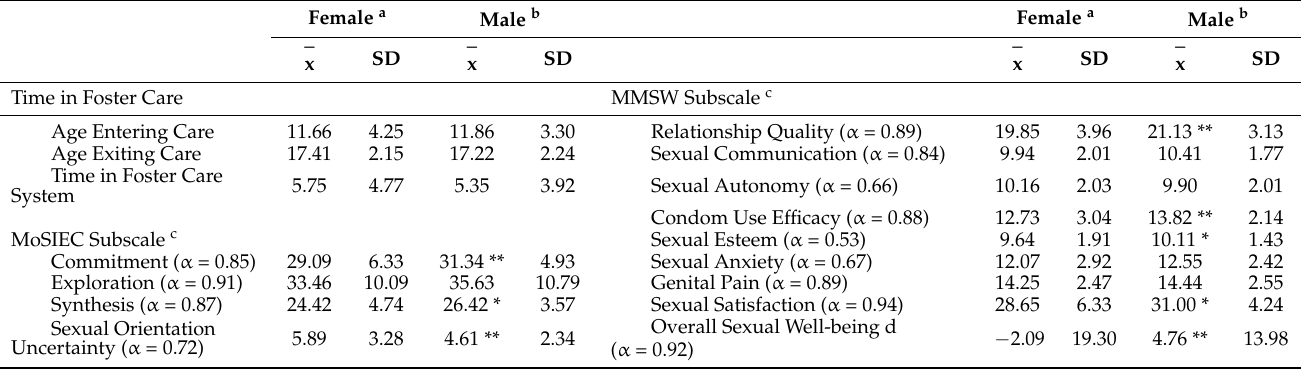
Table 2. Mean Differences Between Male and Female Youth.